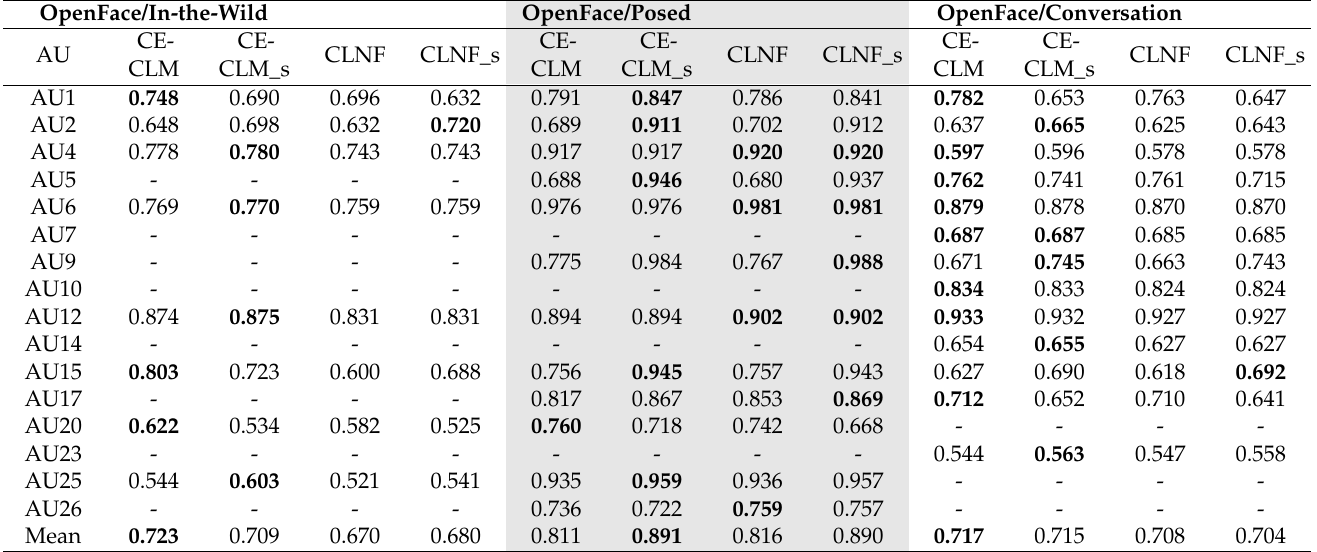
Table 2. Average AUC scores for each AU with all options activated in OpenFace: CE-CLM = convolutional experts constrained local model. CLNF = constrained local neural field model. The letter “s” denotes the analysis of static images. Bold font denotes the highest AUC